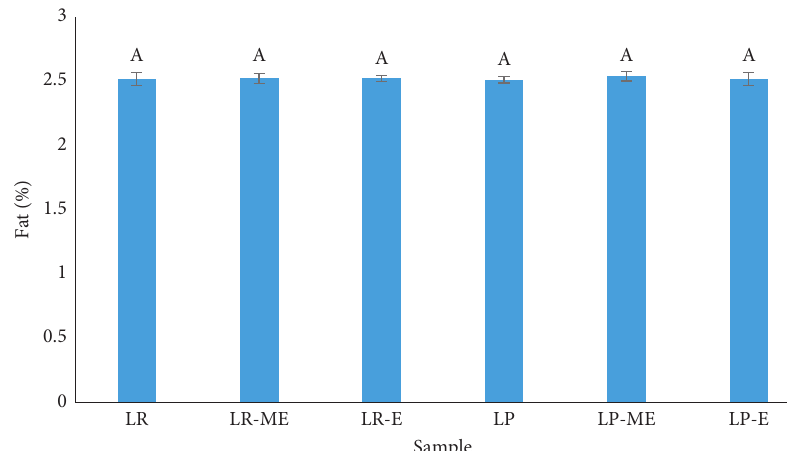
Figure 1: Fat content of probiotic yogurt. LR ( L. rhamnosus ), LR-ME (encapsulated L. rhamnosus in multilayer emulsion), LR-E (en- capsulated L. rhamnosus in emulsion), LP ( L. plantarum ), LP-ME (encapsulated L. plantarum in multilayer emulsion), and LP-E (en- capsulated L. plantarum in